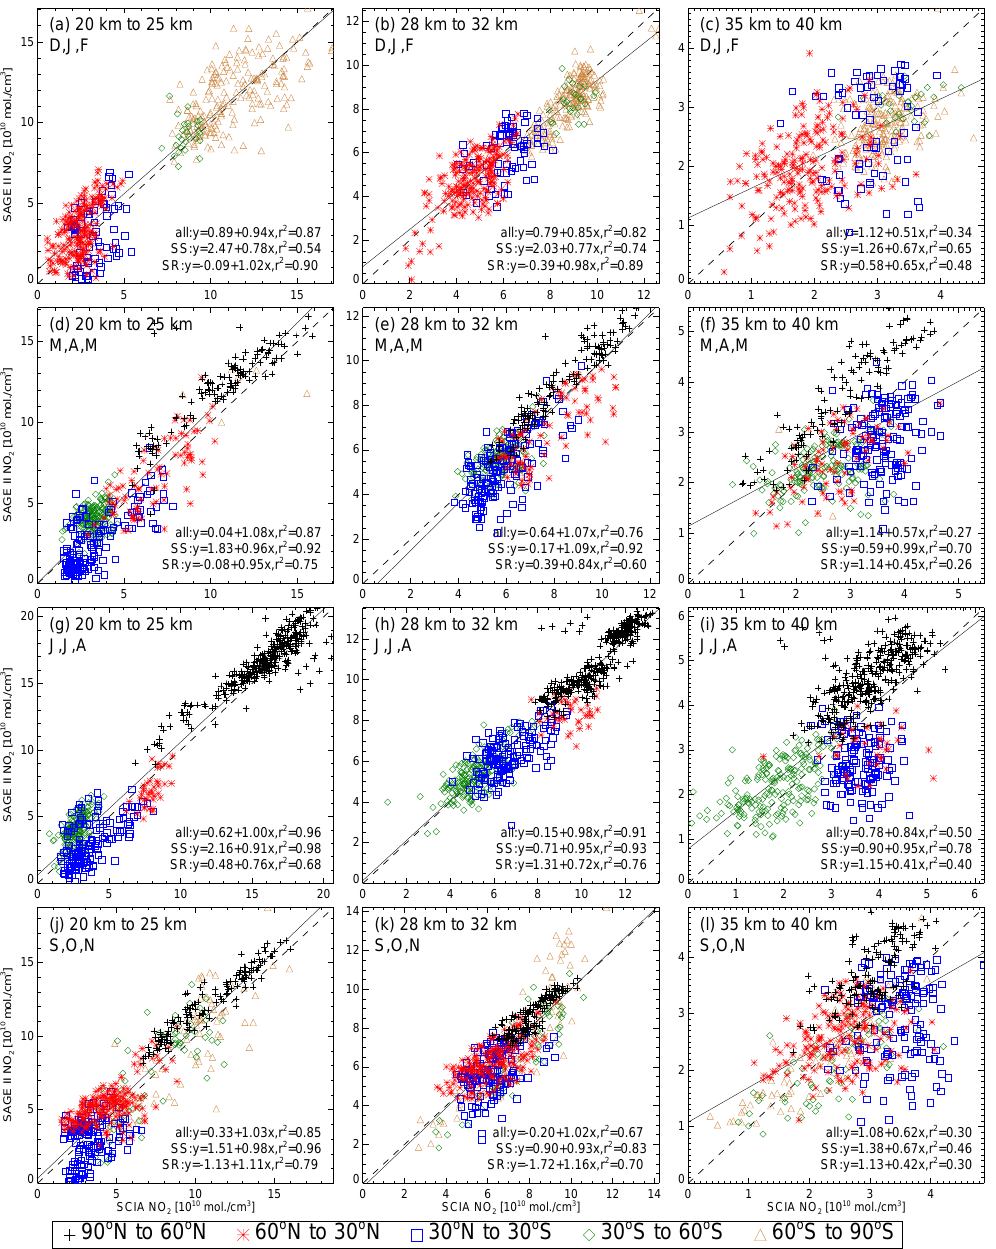
Fig. 8. Scatter plots of collocated SCIAMACHY and photochemically corrected SAGE II NO 2 results for the years 2003 and 2004 are given for partial vertical columns and grouped in 4 seasonal and 3 altitude ranges (20 to 25km, 28 to 32km, and 35 to 40km). 2338 collocation pairs are shown (1121 for SAGE II sunset and 1217 for sunrise). In each panel, collocated pairs from different latitude regions are shown with different colors as given in the legend